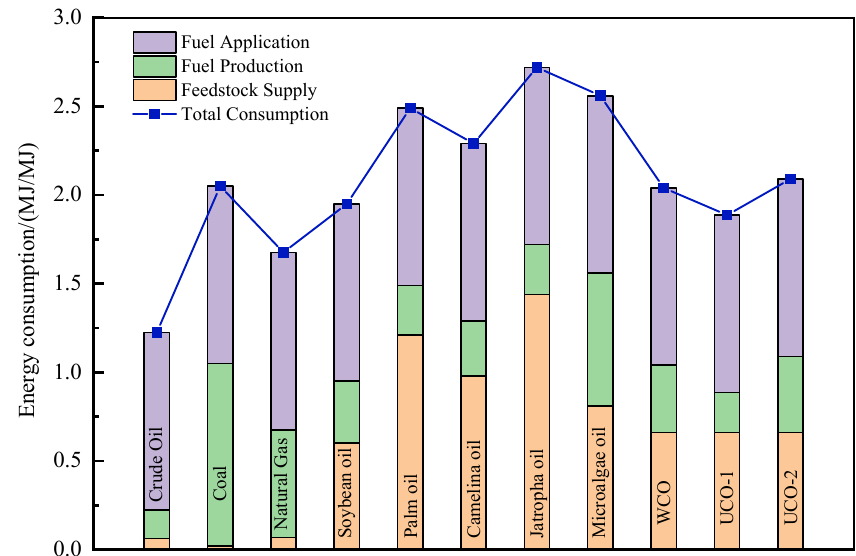
Figure 2. Bio-jet fuel life cycle energy consumption with different feedstock.